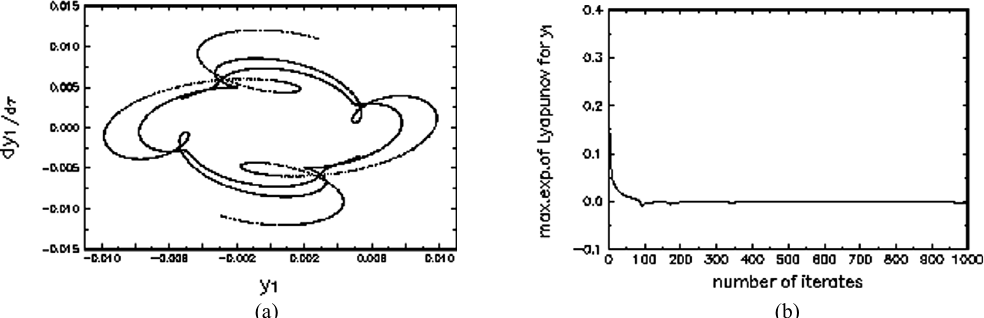
Fig. 10. Poincaré map (a) and Lyapunov exponents (b) of y for γ 4 = 0.0005 and for: a 1 = a 2 = 0.1; a 3 = 0.0001; γ 1 = 0.0001; γ 2 = γ 3 = 0; β 1 = 0.65; c = 1; u 1 = u 2 = 1.5; q =